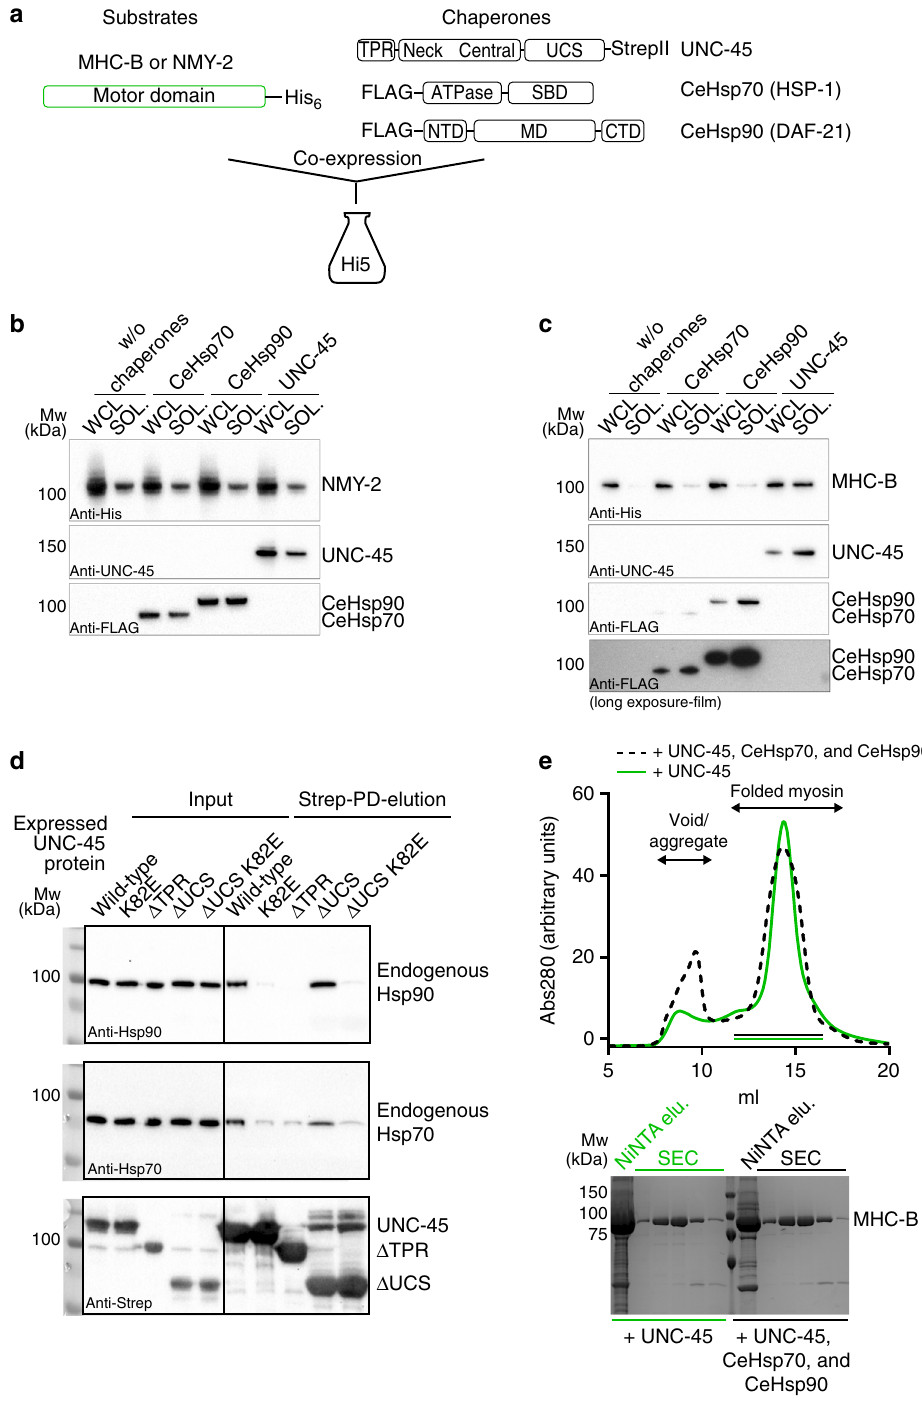
Fig. 1 Producing functional myosin in insect cells. a Overview of constructs used for expression studies in insect cells. Western blot analysis of co- expression of NMY-2 ( b ) or MHC-B ( c ) with indicated chaperones in Hi5 insect cells. Whole cell lysates (WCL) and soluble fractions (SOL) are shown. 1/3rd of the WCL was applied with respect to the SOL fraction. (SBD – substrate binding domain, NBD – nucleotide binding domain, NTD – N-terminal domain, MD – middle domain, CTD – C-terminal domain). d Pull-down (PD) of Strep-tagged UNC-45 constructs from insect cells. Input samples and elutions were probed with Hsp70, Hsp90, and Strep-tag antibodies. e Upper panel: SEC traces of MHC-B puri fi ed from co-expression with the indicated C. elegans chaperones. Lower panel : SDS-PAGE gels showing the elution after NiNTA and indicated SEC fractions different samples, depending on the co-expressed UNC-45 cha- perone. We therefore used the SEC-puri fi ed amounts of mono- meric, folded MHC-B (Fig. 2d) together with the data from our cellular assay (Fig. 2b and Supplementary Fig. 2a) as a readout to assess the chaperone activity of the different UNC-45 forms. NATURE COMMUNICATIONS| (2019) 10:4781